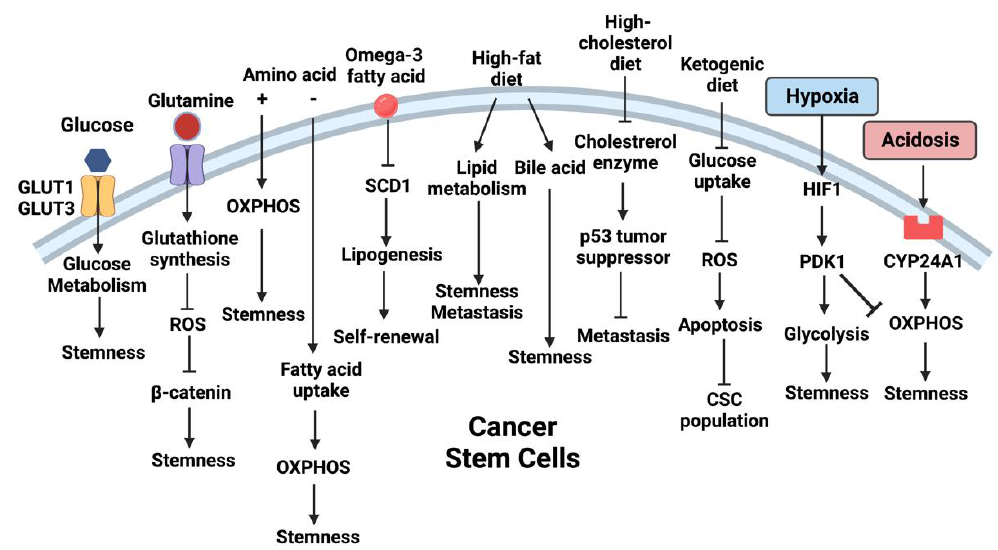
Figure 1. TME and extracellular metabolites reprogram CSC metabolism. Schematic diagram illus- trating the effects of TME metabolites, diet and environmental factors on regulating the metabolism and functions of CSCs.